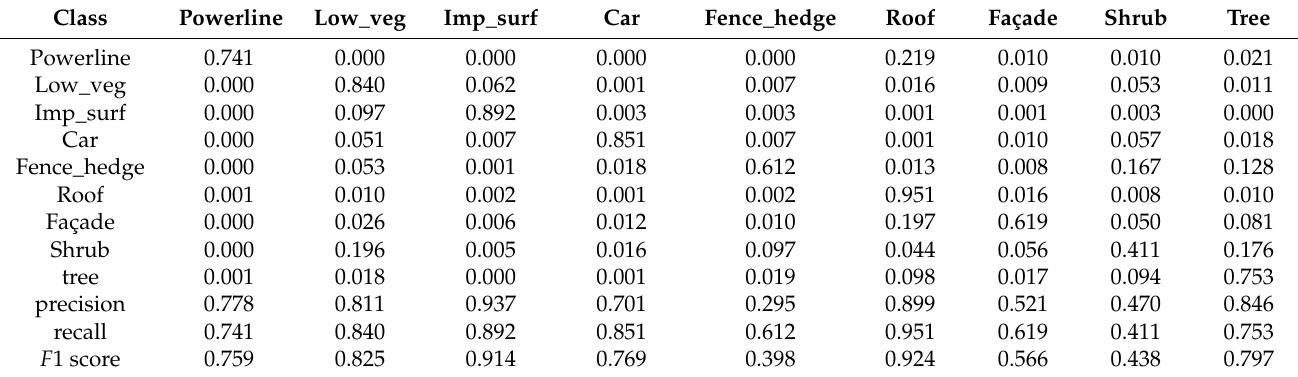
Table 6. The confusion matrix of our proposed method with per-class precision on the Vaihingen 3D test set.